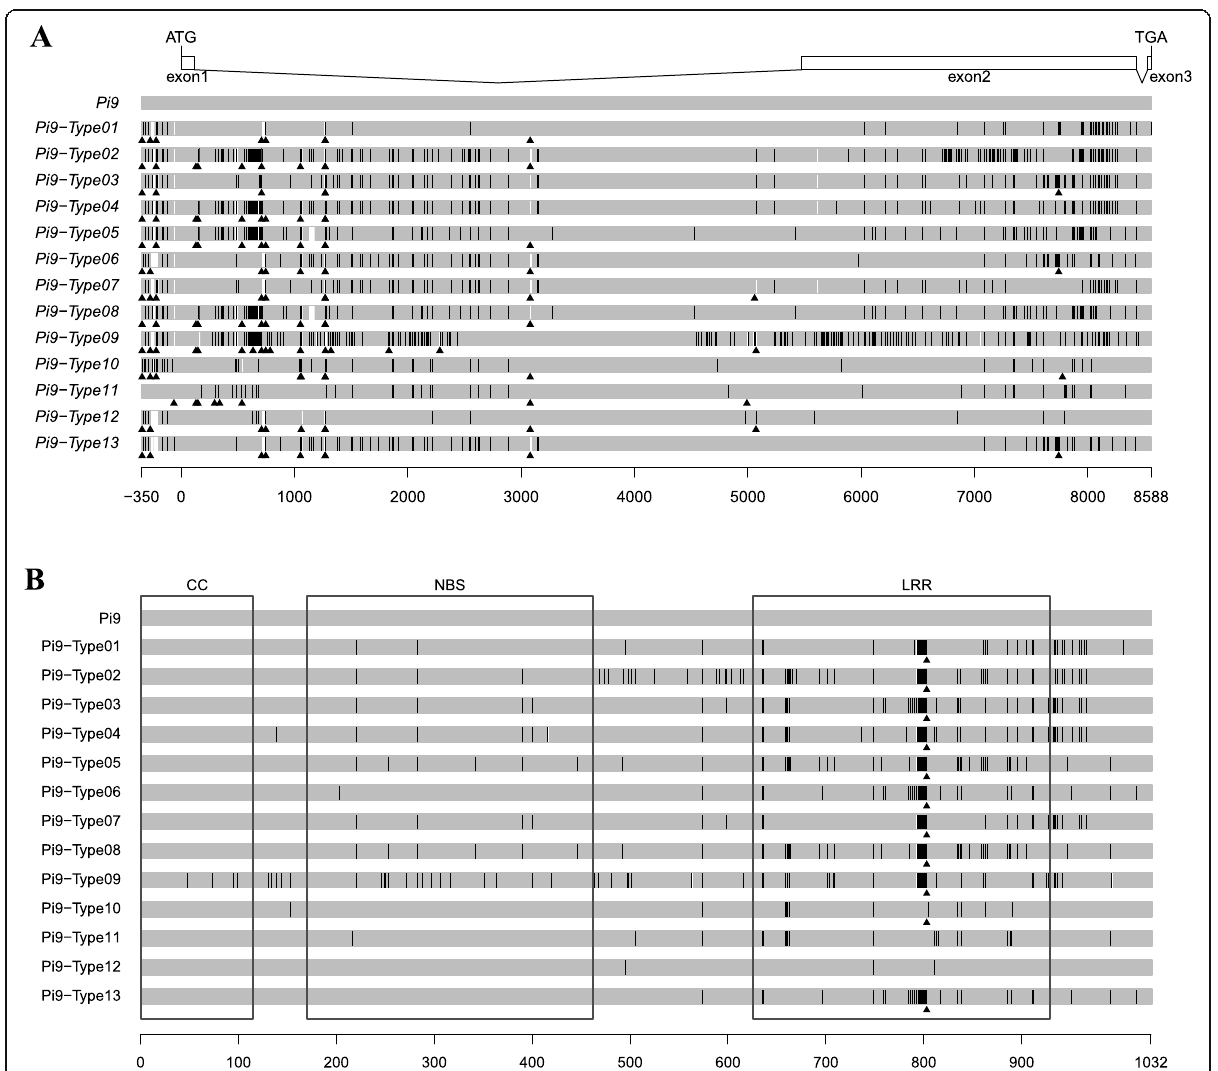
Fig. 1 Schematic map for sequence alignment of newly identified Pi9 allele gene ( a ) and protein ( b ) . a .Thirteen alleles of Pi9 were isolated from the studied rice accessions and compared with Pi9 gene. Boxes indicate exons and lines indicates introns, and the start codon and the termination codon are labeled with ATG and TGA, respectively, in the figure above. The unit scale indicates the location of nucleotides. b Thirteen alleles of Pi9 protein compared with Pi9 protein. The domain regions of the Pi9 alleles protein are shown as boxes (CC, NBS and LRR) in the picture. CC, coiled-coil domain; NBS, nucleotide-binding site; LRR, leucine-rich repeats. The unit scale indicates the location of amino acids.The black lines on the bar indicate the nucleotide or amino acid polymorphism compared with the reference sequence. The white strips indicate deletion, and the size of gaps indicate the length of deletion sequence. Triangles indicate